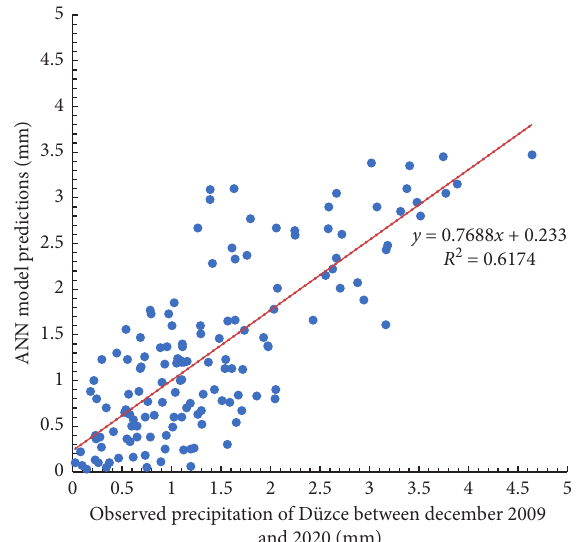
Figure 7: The correlation among ANN model outputs and observed records of D¨uzce